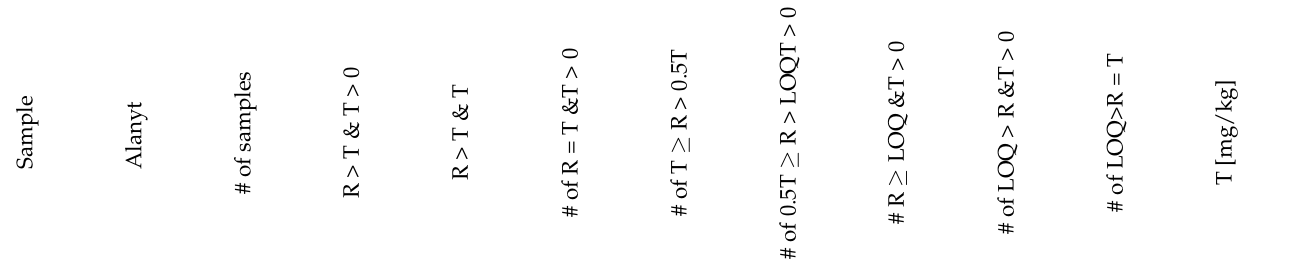
Table A6. Distribution of residues in MRL ranges 1 .